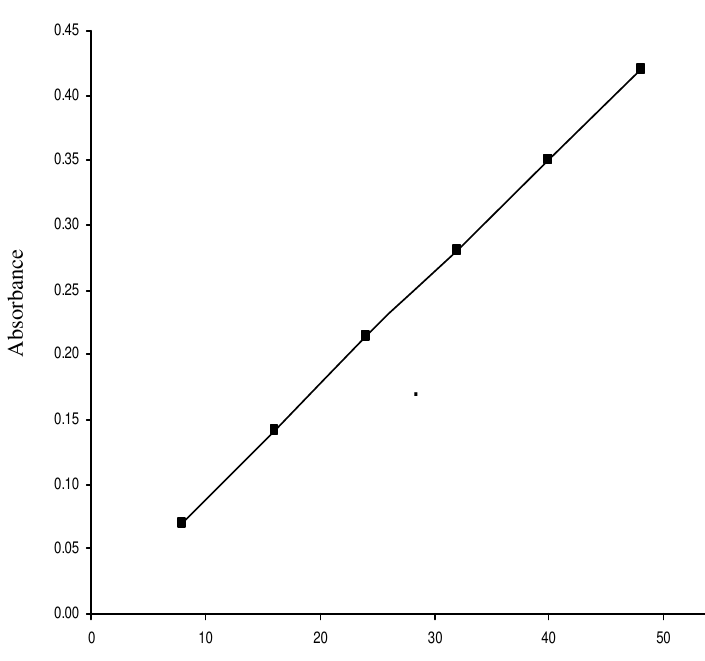
Figure 1. Beer’s law plot of BUCZ - TA/PMAP - Cr (VI)